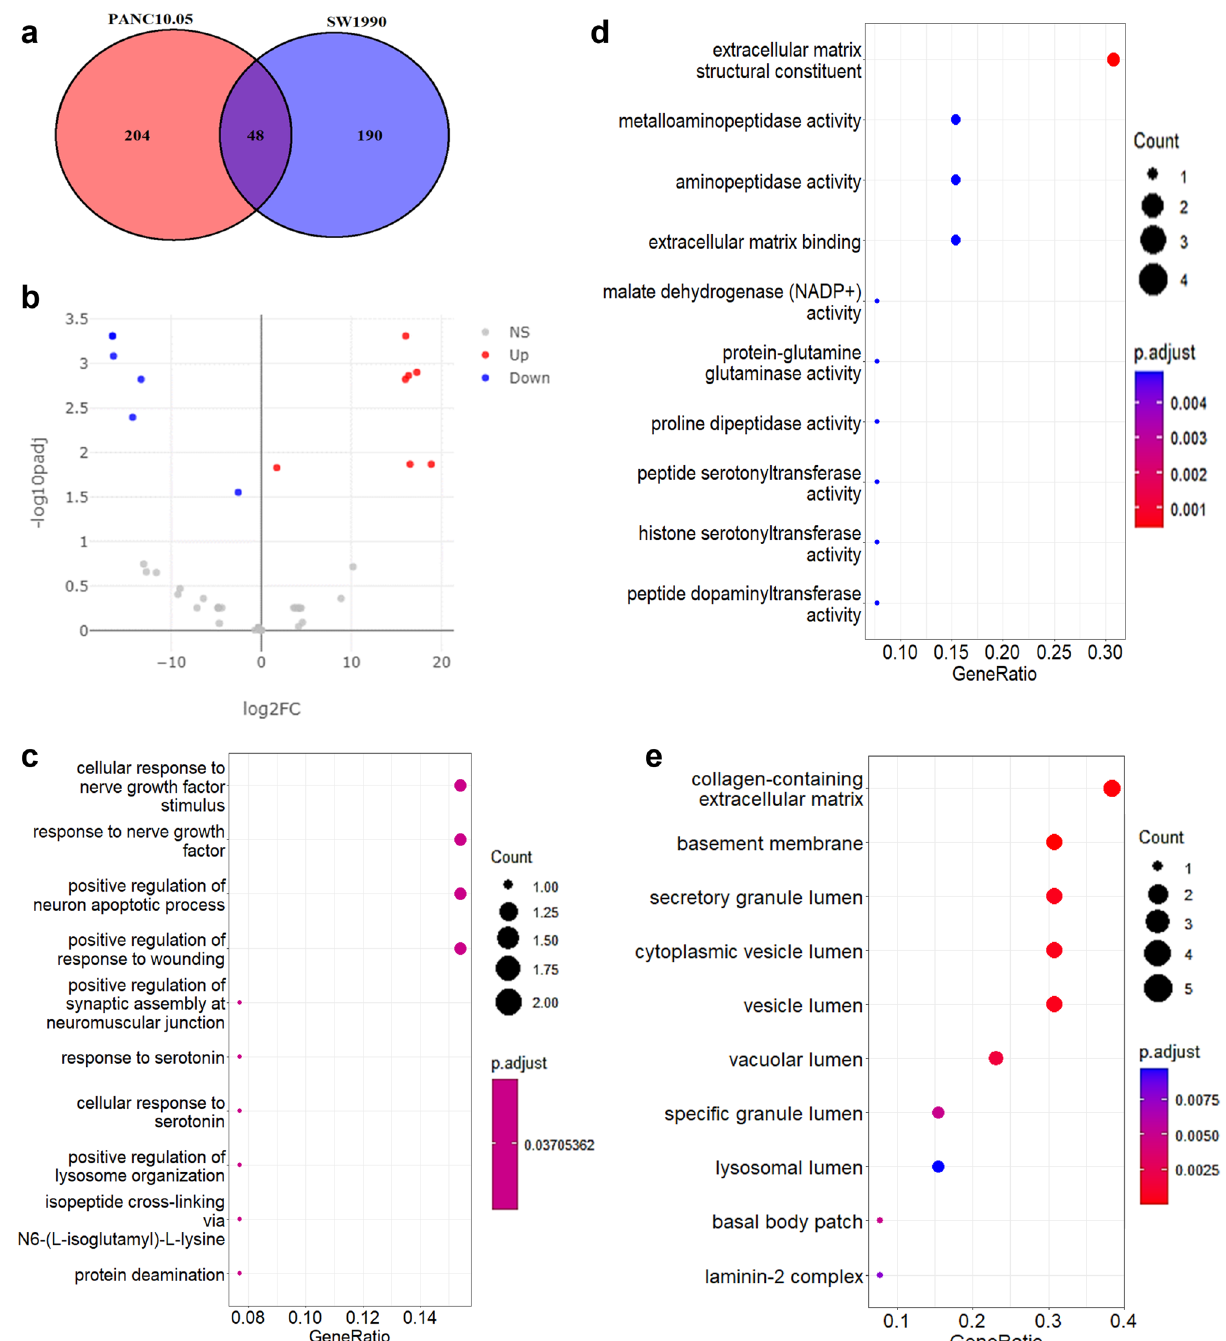
Figure 2. The proteomic profiling of PANC10.05 and SW1990. ( a ) Venn diagram for the number of proteins expressed by each cell line. Number in the intersection represents the number of expressed proteins shared by PANC10.05 and SW1990. ( b ) Volcano plot of the DEPs between PANC10.05 and SW1990. ( c – e ) Gene Ontology enrichment analysis of differentially expressed proteins (DEPs). X-axis represents the gene ratio and Y-axis represents the corresponding GO term. ( c ) Ontology = Biological Process; ( d ) Ontology = Molecular Function; ( e ) Ontology = Cellular